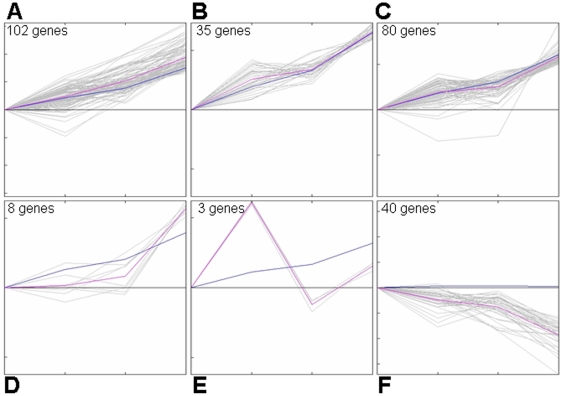
Patterns of expression kinetics among the four subsets of CD4 single positive thymocytes based on SOM analysis.(A–F) Six patterns of expression kinetics are shown.